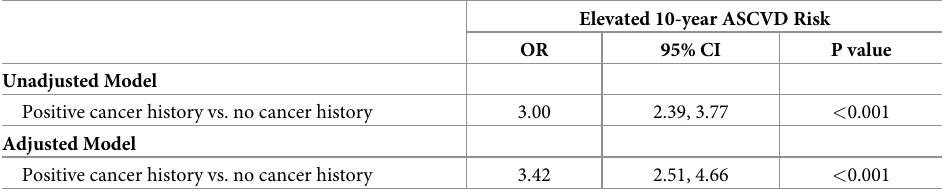
Table 3. Odds ratios (ORs) and 95% confidence intervals (CIs) for associations between cancer status and elevated vs. low 10-year ASCVD risk based on Pooled Cohort Equations, 2007–2016 NHANES.